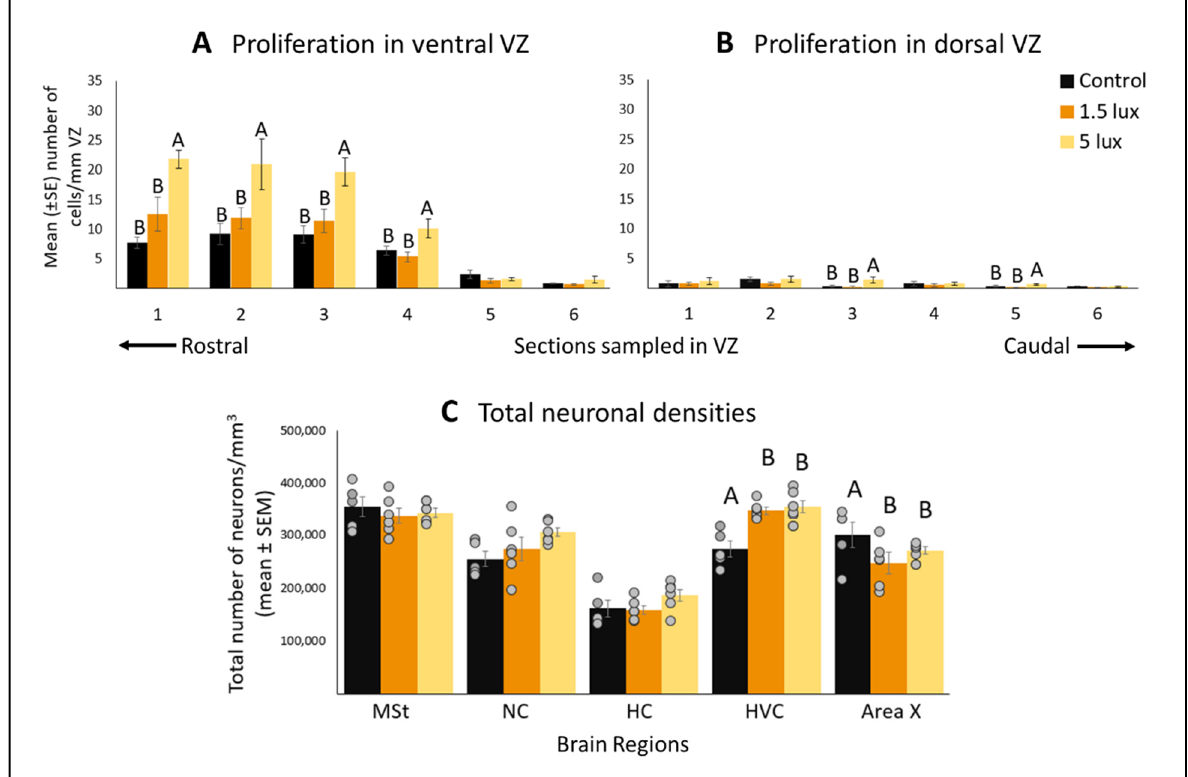
Figure 6. Cell proliferation (number of cells/mm; mean ± SE) in ventral ( A ) and dorsal ( B ) walls of the VZ, in brains of birds exposed to ALAN (1.5 and 5 lux) and controls that were exposed to complete darkness at night. Six sections were sampled along the rostral-caudal axis of the VZ (for details see Figure 4). Total neuronal densities (number of neurons/mm 3 ; mean ± SE; ( C )) in the brain regions MSt (medial striatum), NC (nidopallium caudale), HC (hippocampus), HVC, and Area X, of birds exposed to 1.5- and 5 lux ALAN, and controls that were exposed to complete darkness at night. Grey dots indicate individual data points, different letters indicate significant differences (Tukey post hoc tests, following one-way ANOVAs within each section). n = 6 birds per group. When no letters are mentioned, there is no difference among groups.